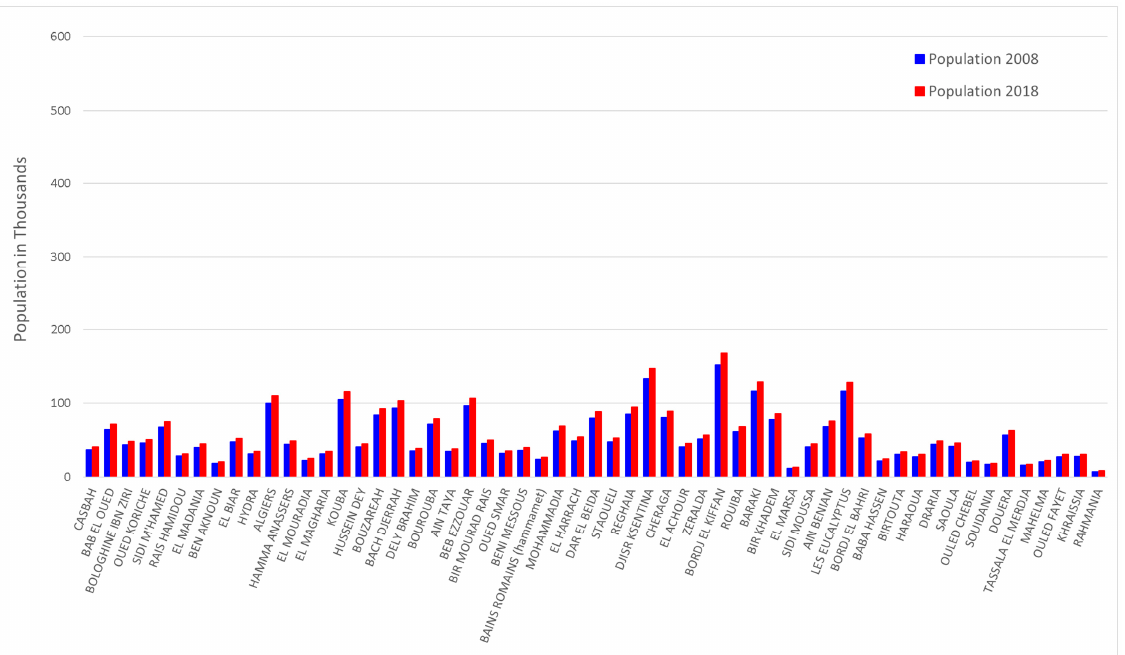
Figure 12. Population (thousands of persons) for the communes in the Algiers wilaya between 2008 and